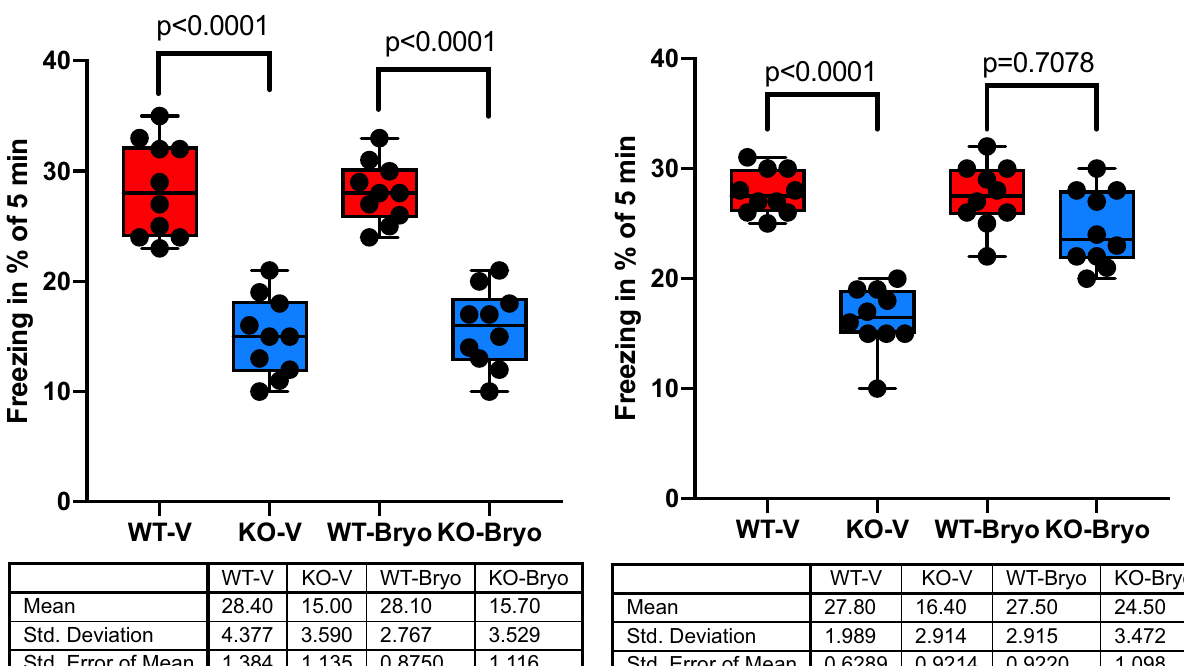
Figure 4. Chronic bryostatin-1 rescues impaired learning and memory of the Fmr1 KO2 mice in contextual fear conditioning. Wild-type (WT) or Fmr1 KO2 (KO) adult mice were treated with vehicle (V) or bryostatin-1 (Bryo) for 5 weeks (Study 1) or 13 weeks (Study 2) and then tested in contextual fear conditioning. Significant improvement in cognitive behavior is observe in Fmr1 KO2 mice following chronic treatment with Bryostatin 1 for 13 week when compared to wild type littermates ( P = 0.7078). Data is visualized as boxplots with interquartile ranges, presenting all the data points. The table indicates the mean standard deviation and the standard error of the mean (N = 10 mice per